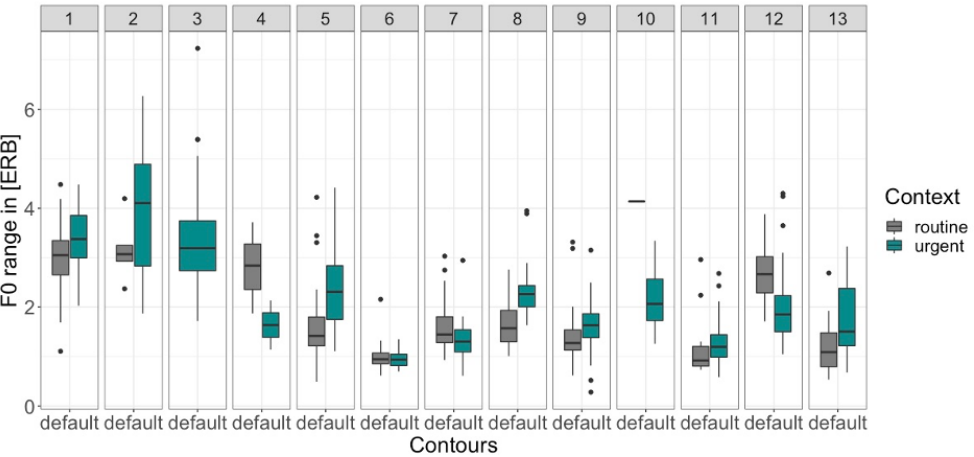
Figure 14. F0 range in the routine and urgent context for the default contour in CF